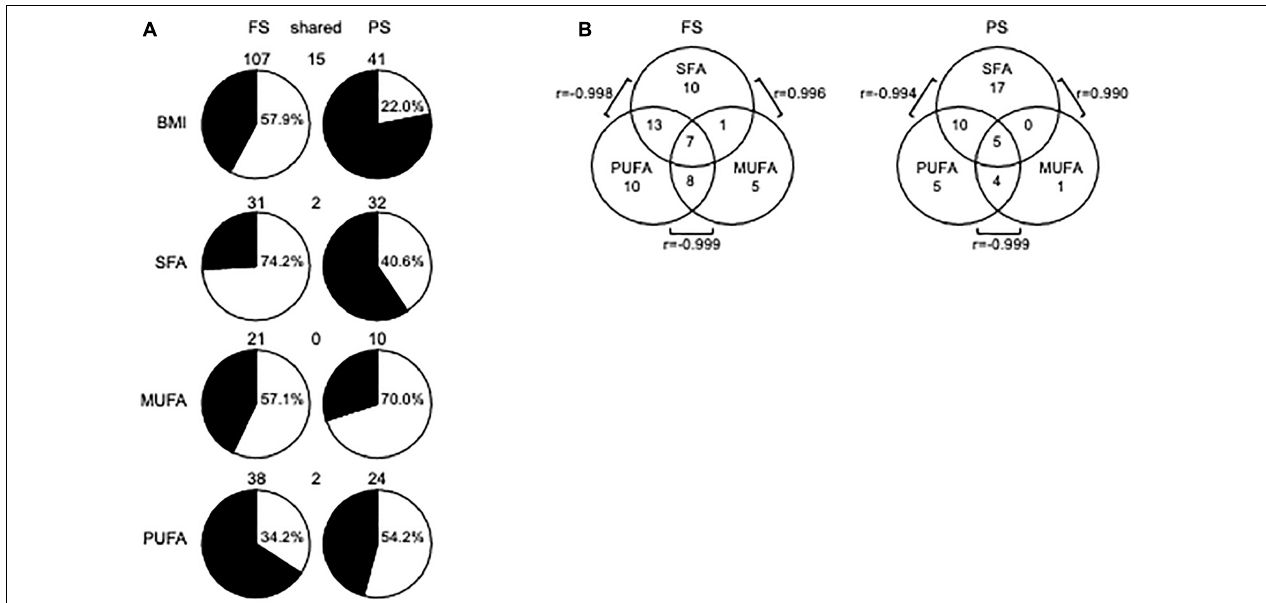
FIGURE 1 | DmCpG in associations with BMI or FA. (A) Prandial state-dependent associations of DNA methylation with BMI, SFA, MUFA, and PUFA. In pie charts, white and black indicate hypomethylated (negatively associated) and hypermethylated (positively associated) BMI-dmCpG, SFA-dmCpG, MUFA-dmCpG, and PUFA-dmCpG sets, respectively. Hypomethylated dmCpG percentage is indicated in each pie chart. DmCpG counts are indicated above the respective pie chart. (B) Shared dmCpG among SFA, MUFA, and PUFA. r -values show correlations between shared dmCpG across saturation groups.